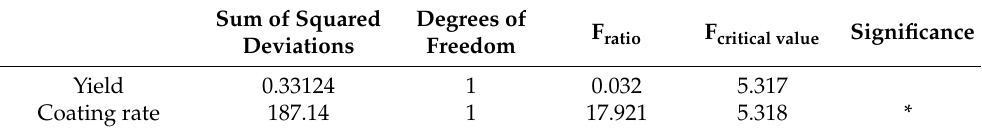
Table 9. Variance analysis of yield and coating rate in single factor test.